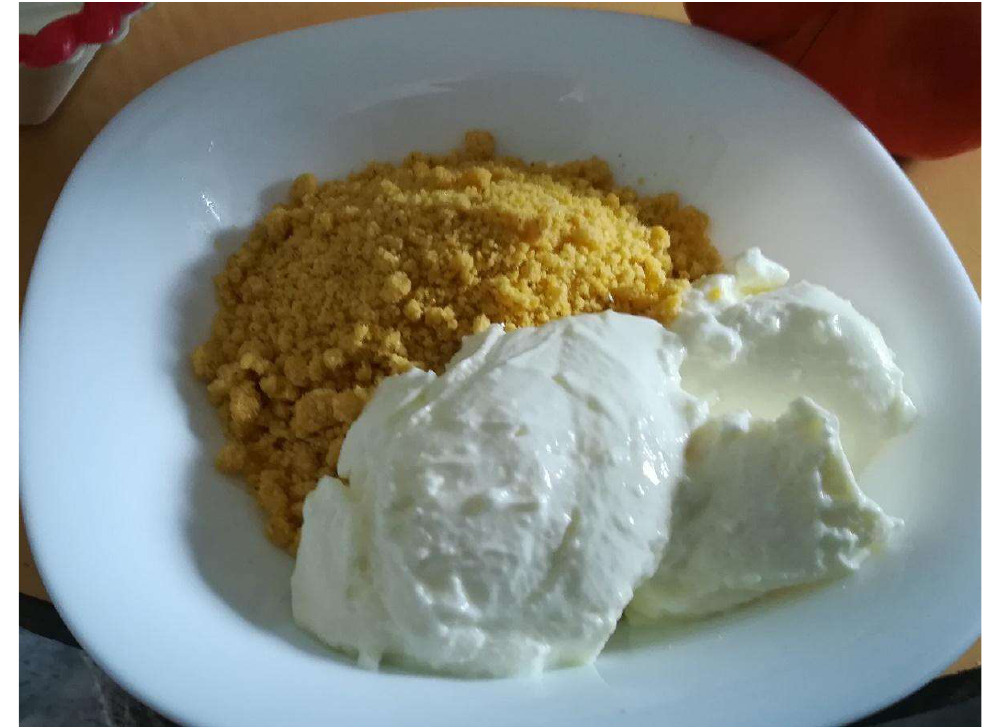
Figure 4. Bagertar me kos (maize crumbles served with homemade strained yogurt, photo: A. Pie- roni).